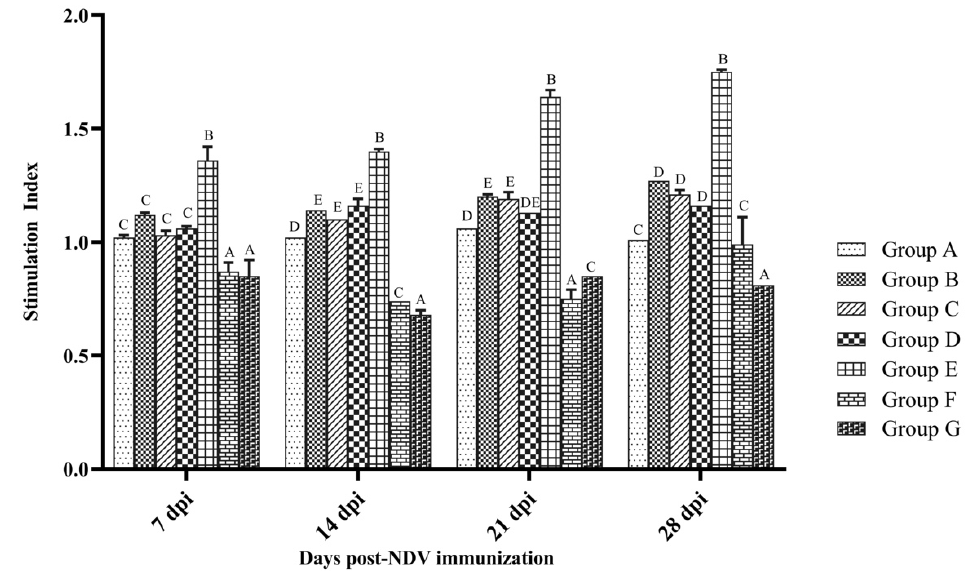
Figure 3. Lymphocyte transformation specific to NDV antigen in PBMCs collected from SPF chicken following immunization. Treatment effect was analyzed at each time point by two-way ANOVA with Tukey’s test as post hoc test. The probability of an alpha error was set at 0.05. Different superscripts above bars (mean ± SE) indicate significant difference between groups ( p < 0.05). Group A: